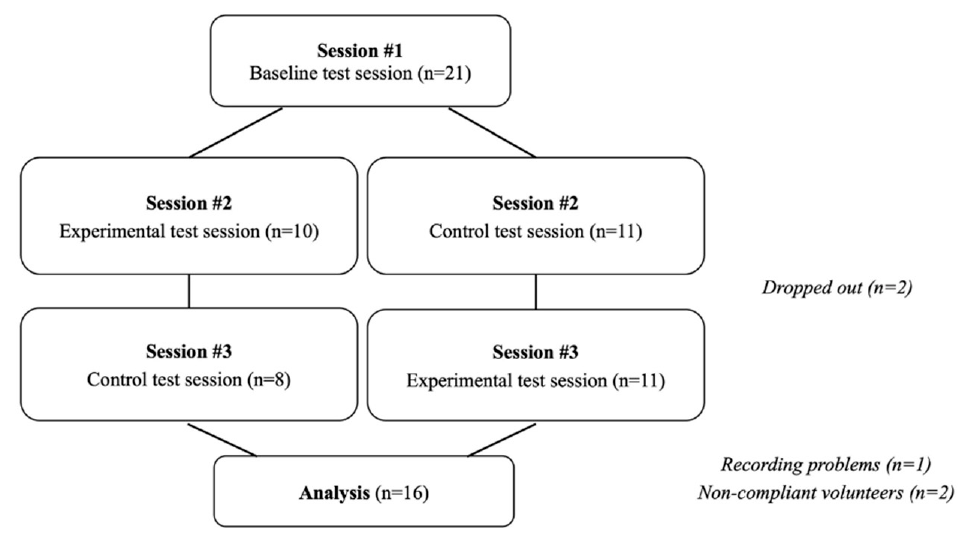
Figure 3. Study flowchart. Results of the repeated-measure analysis of variance and data are presented in Tables 2 and 3, respectively. As indicated, significant main effects were obtained for (i) the CoP Area during the bipedal balance test eyes closed (Shoes factor), (ii) the CoP Length during unipedal balance test (Session factor) and (iii) 315 ◦ stability limit (Shoes factor). Post hoc analysis performed on the bipedal balance (eyes closed) revealed a significantly smaller rea with the balance shoes as compared to that with the personal shoes ( p = 0.0475). Post hoc analysis conducted on unipedal balance revealed significantly smaller CoP length with the balance shoes during both the experimental and control sessions as compared to that of the baseline ( p = 0.0319 and p = 0.0151, respectively). Lastly, the limit of stability was lower at 315 ◦ with balance shoes as compared to that with the personal shoes ( p = 0.0165). Table 2. Results of repeated measure analysis of variance ( p